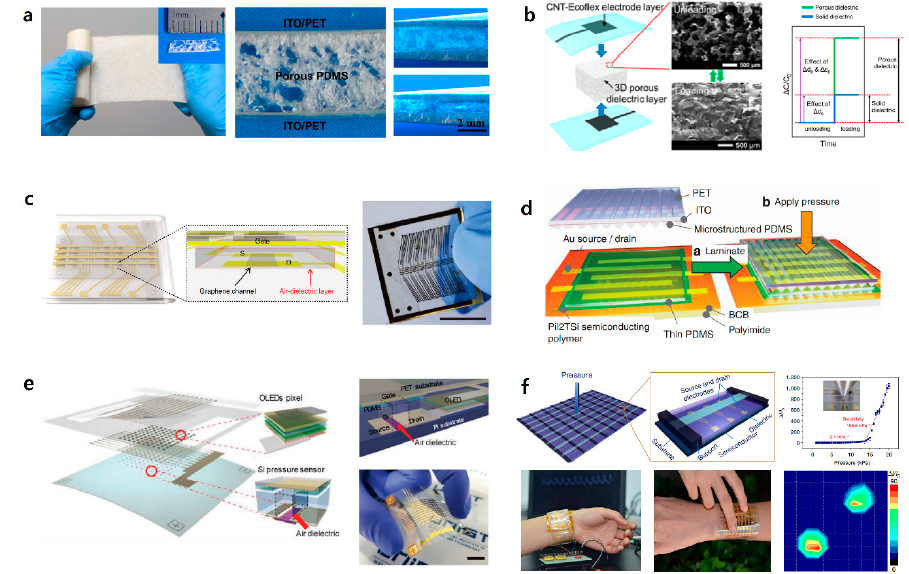
Figure 6. Results of dielectric layer modification. ( a ) The photo image of the fabricated large area microstructured polydimethylsiloxane (PDMS) film (the inset shows the cross-sectional photo image of the microstructured PDMS film) (left); The cross-sectional photo images of the microstructured PDMS film clipped by a tweezer without pressure (upper) and with pressure (bottom) (right). ( b ) Relative changes in the capacitances of pressure sensors using solid and porous elastomeric dielectric layers induced by identical levels of external loading. The synergy of the larger deformation by the reduced stiffness and the increased effective dielectric constant by the closure of the air gap dramatically amplifies the capacitance change. ( c ) Schematic images of pressure-sensitive graphene FETs with air-dielectric layers after the folding. The air-dielectric layer is placed between the graphene channel and the gate electrode as illustrated in the schematic image (inset) (left); Photograph of the fabricated pressure-sensitive graphene FETs; scale bar, 1 cm (right). ( d ) Schematic of the final fabrication step of our pressure-sensitive transistor. ( e ) Schematic of active-matrix pressure-sensitive display, integrating the Si tactile pressure sensors and organic light-emitting diodes (OLEDs). ( f ) Suspended gate organic thin-film transistor pressure sensors. (a) Reproduced with permission [94]. (b) Reproduced with permission [95].